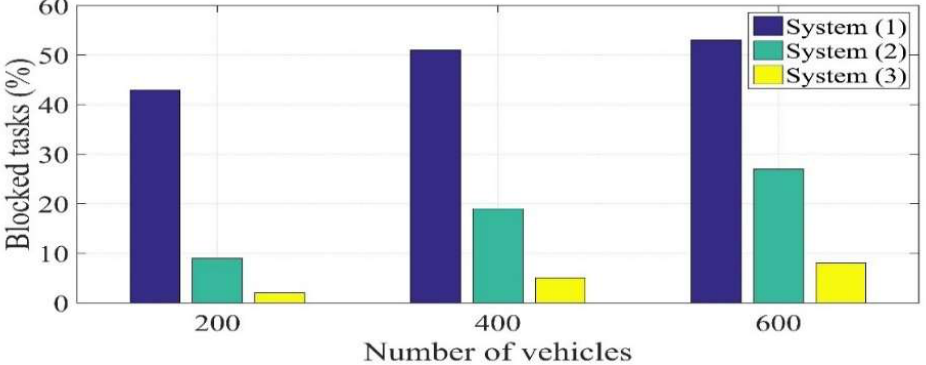
Figure 8. Percentage of blocked tasks for the three systems with different numbers of vehicles.